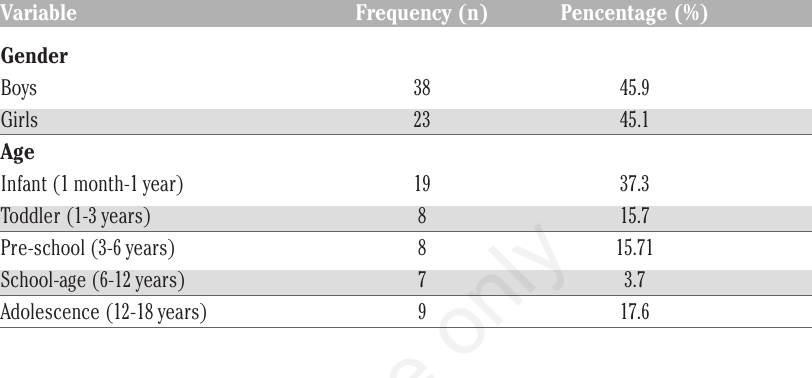
Table 1. Distribution of participants based on gender and age in PICU.